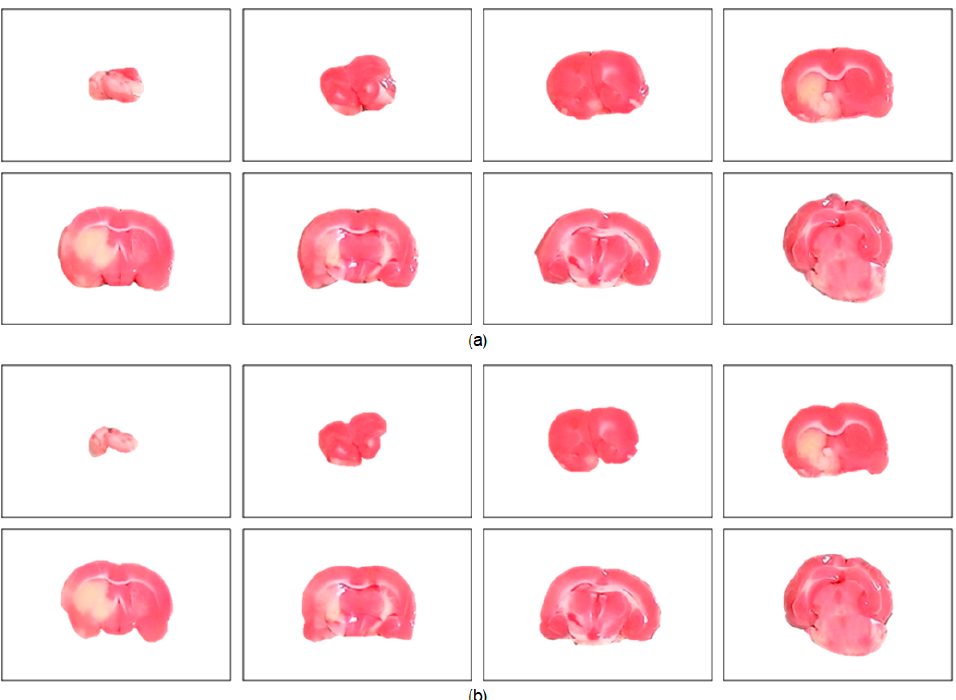
Figure 3. Visual evaluation of the rat brain extraction results of Subject 37. There are eight brain slices extracted from a large compound image (Figure 1) and stored in the same 480 × 320 image. ( a ) The proposed algorithm. ( b ) The gold standard.